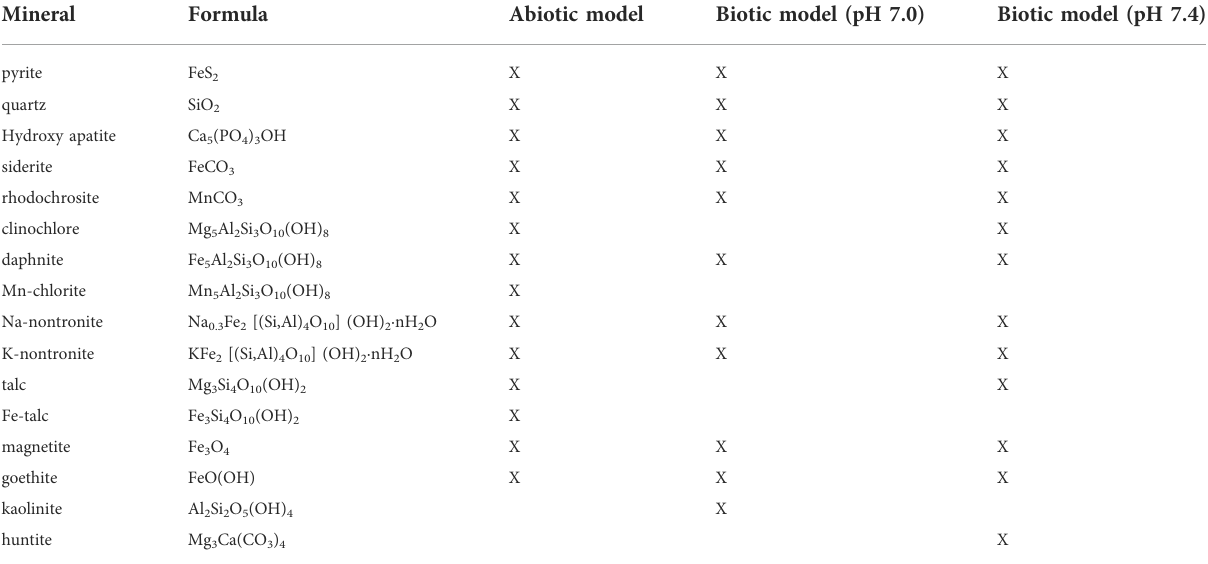
TABLE 4 List of minerals that form in abiotic and biotic models at 14 ° C, 2 bar between (W/R) M of 10 6 and 1.